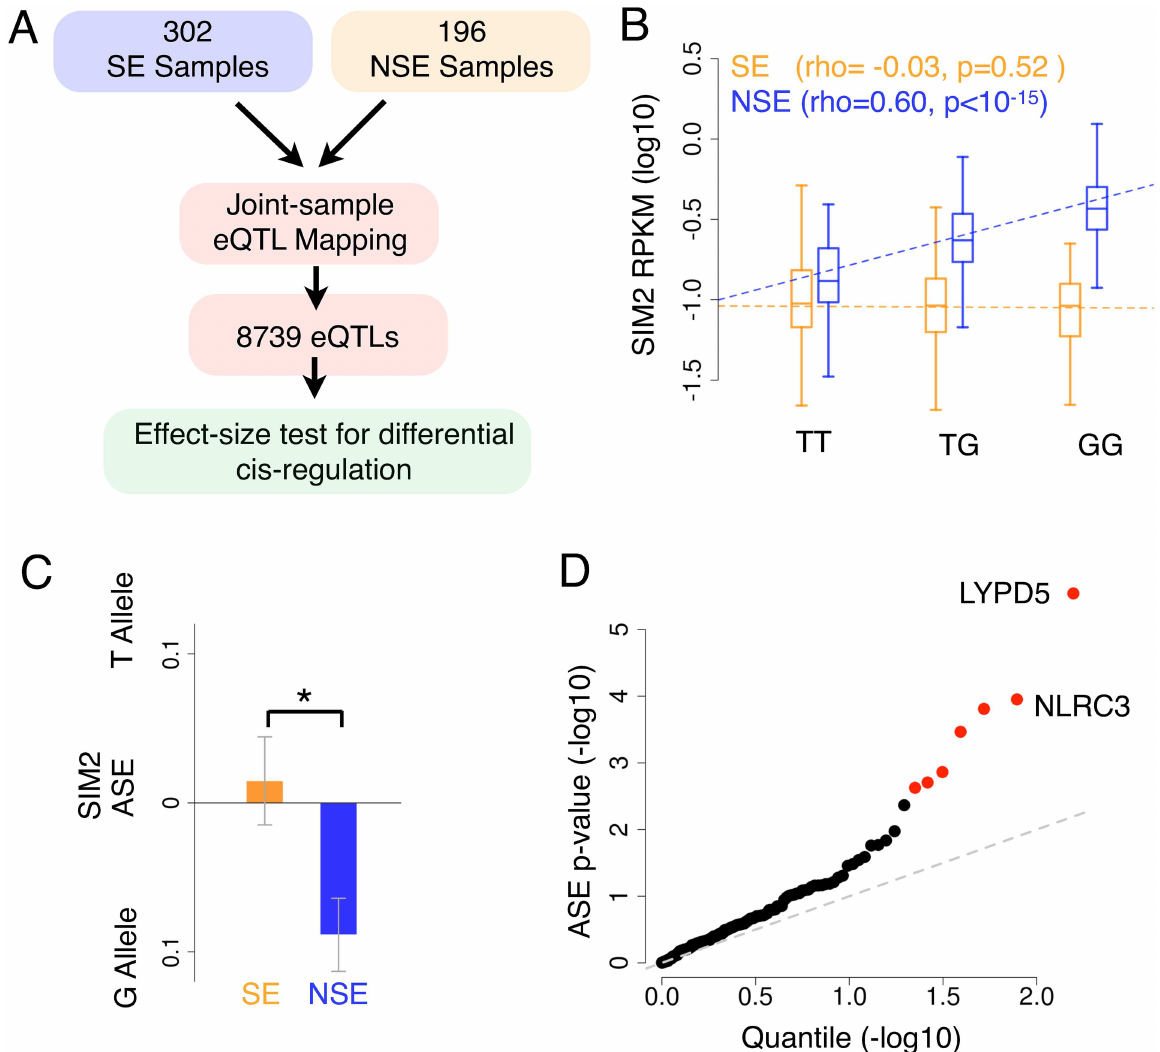
Fig 2. Differential cis-eQTL mapping and validation with ASE. (A) Outline of our approach to mappingdifferential cis-regulation. (B) The expression of SIM2 for each exposure-type after segregation by genotype at the eQTL (rs2248813). P-values are from the asymptotic approximation of the Spearman correlation(rho). (C) ASE validationof the SIM2 result for individualsheterozygous at the eQTL. The allele on the y-axis indicates the allele at the eQTL (see x-axis of panel B), and the ASE directionalities were phased based on these alleles. * indicates p-value < 0.05 by t-test. (D) QQ plot of each tested gene after combiningthe effect size test and the differential ASE test. Red indicatesthe gene had a significant GxE expressioninteraction with a SNP (FDR < 0.05, Benjamini-